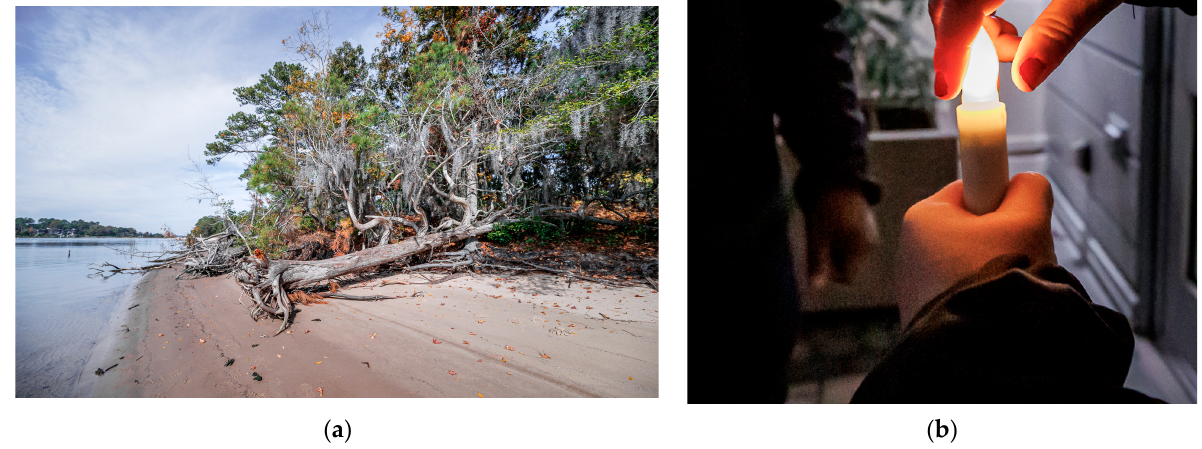
Figure 3. Images were uploaded to Flickr by the author and retrieved on 7 February 2023, with the Flickr search API. ( a ) is an outdoor image tagged with a correct label. ( b ) is an indoor image but tagged as “outdoor”. The copyright of both images was obtained from the city of Virginia Beach.